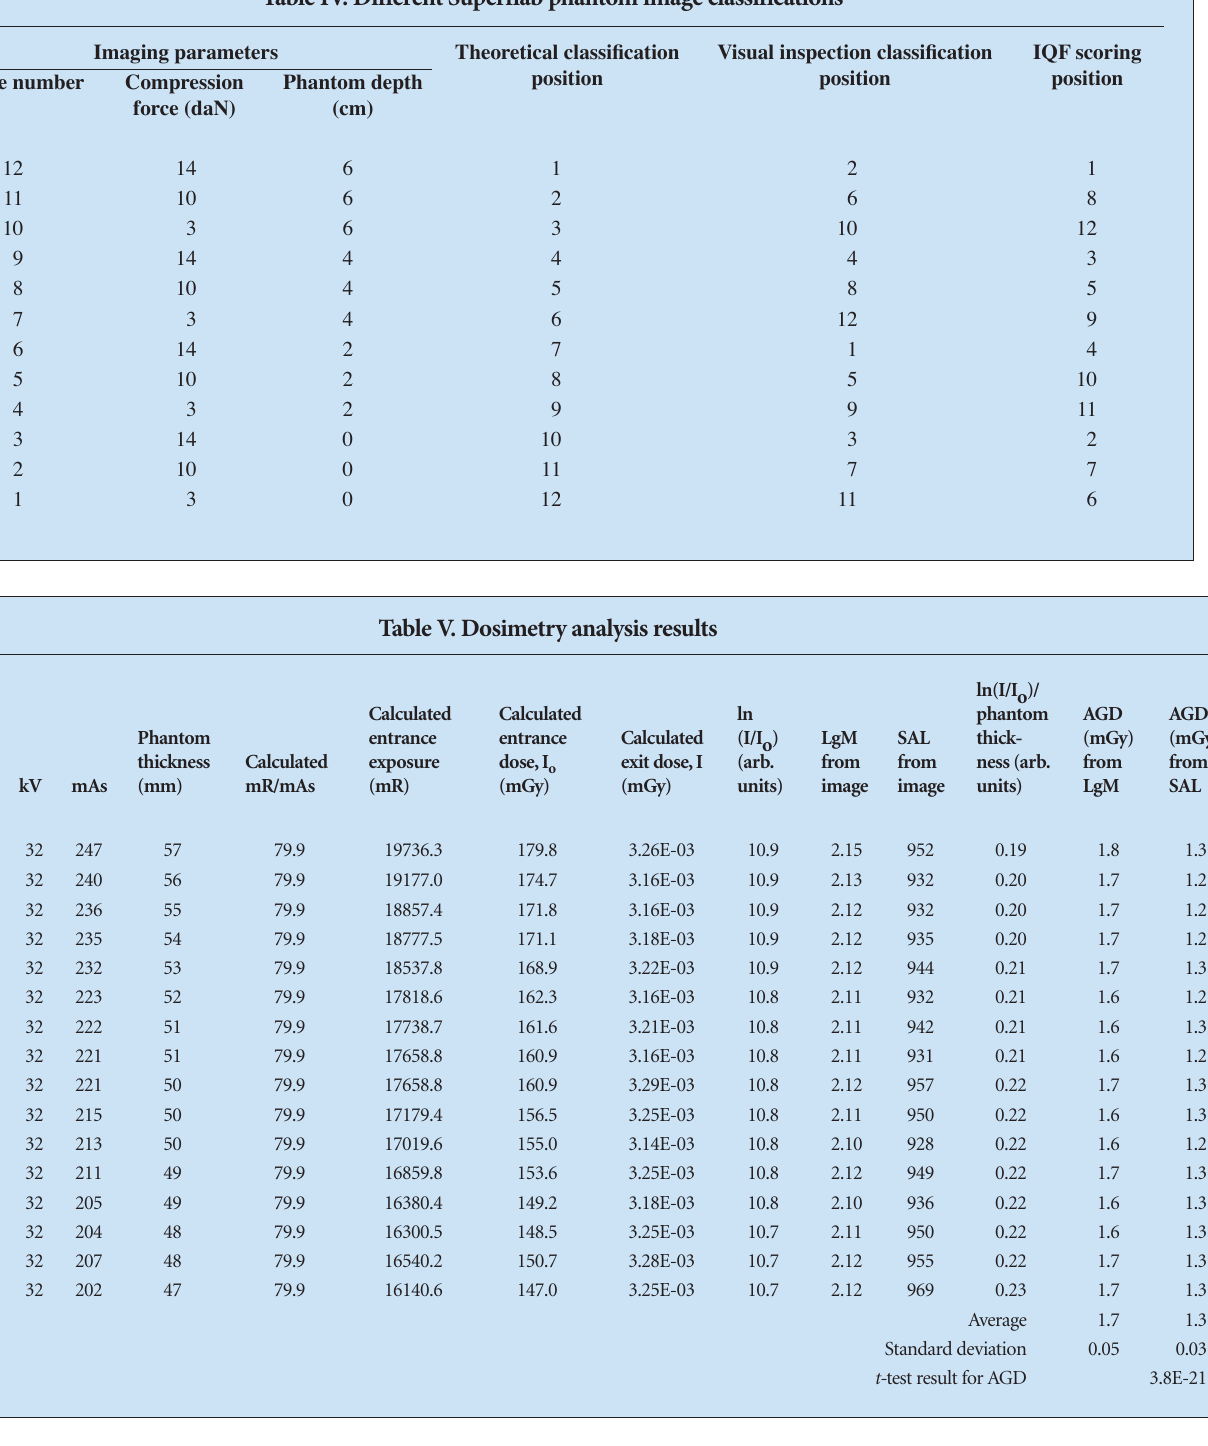
Table IV. Different Superflab phantom image classifications